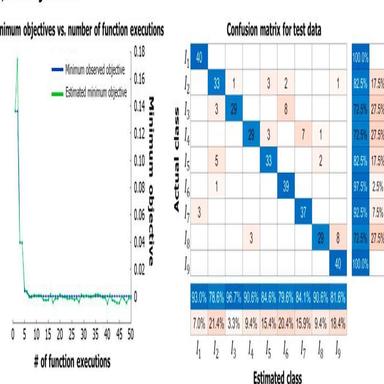
Performance evaluation results for the optimized CNN-based deep learning model for impact localization.